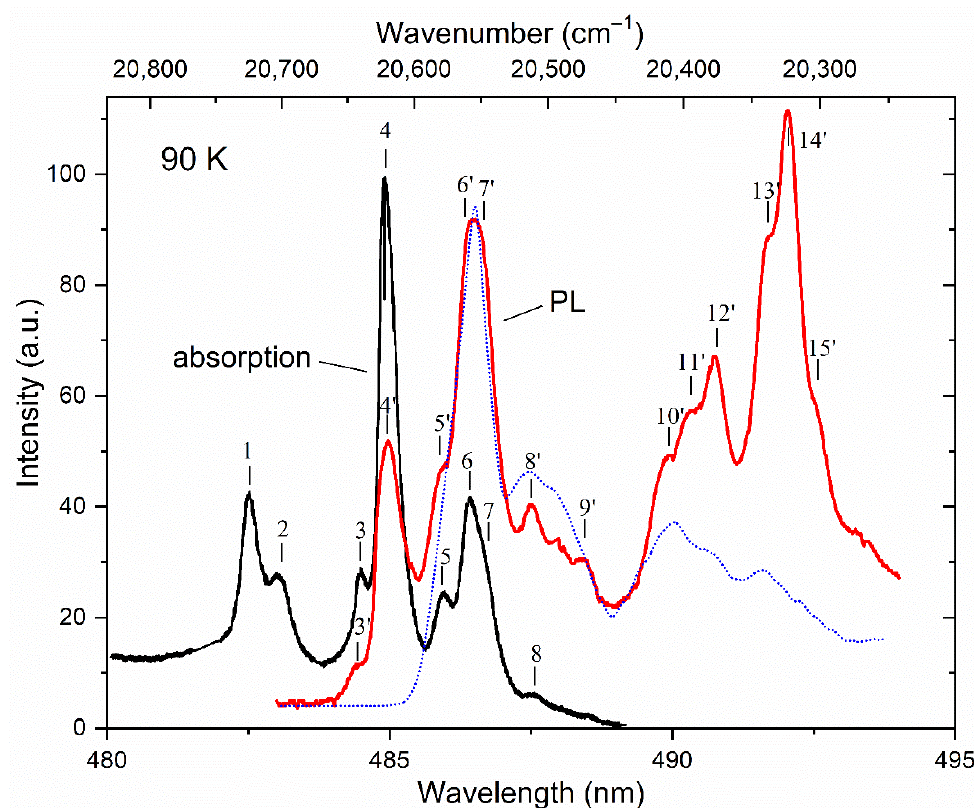
Figure 4. Low-temperature absorption (black) and PL (red) spectra of a KTF crystal under Hg lamp excitation. The PL data measured at T = 3 K [19] are shown as a dotted line for comparison. Peaks in the spectra are indicated by numbers.